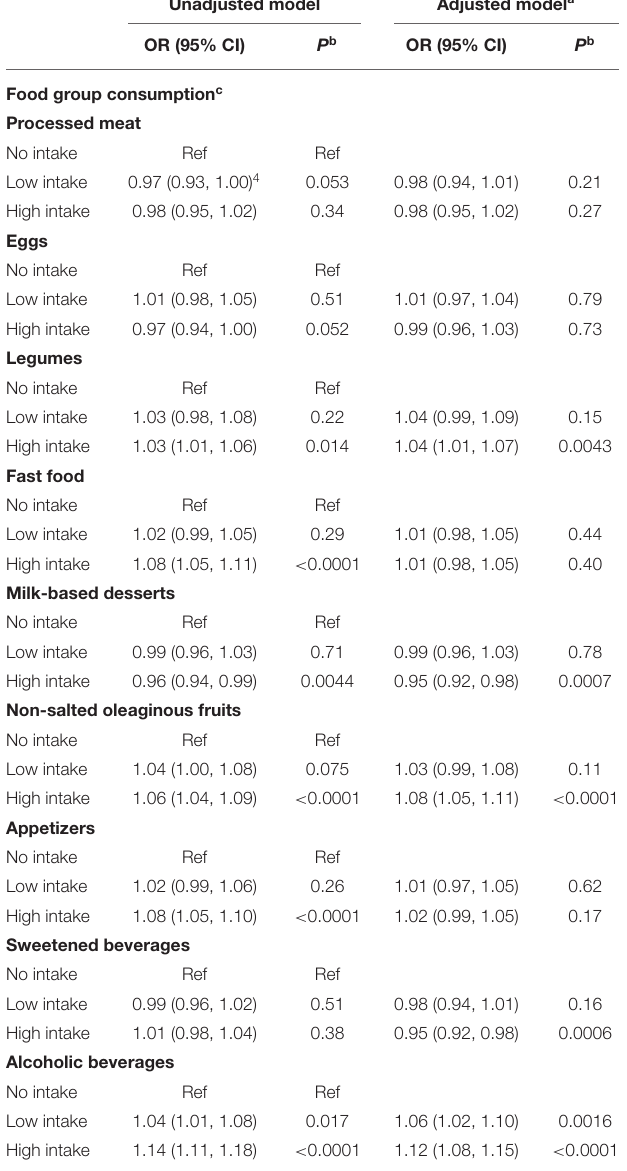
e Classification of eating disorders categories based on the Expali algorithm